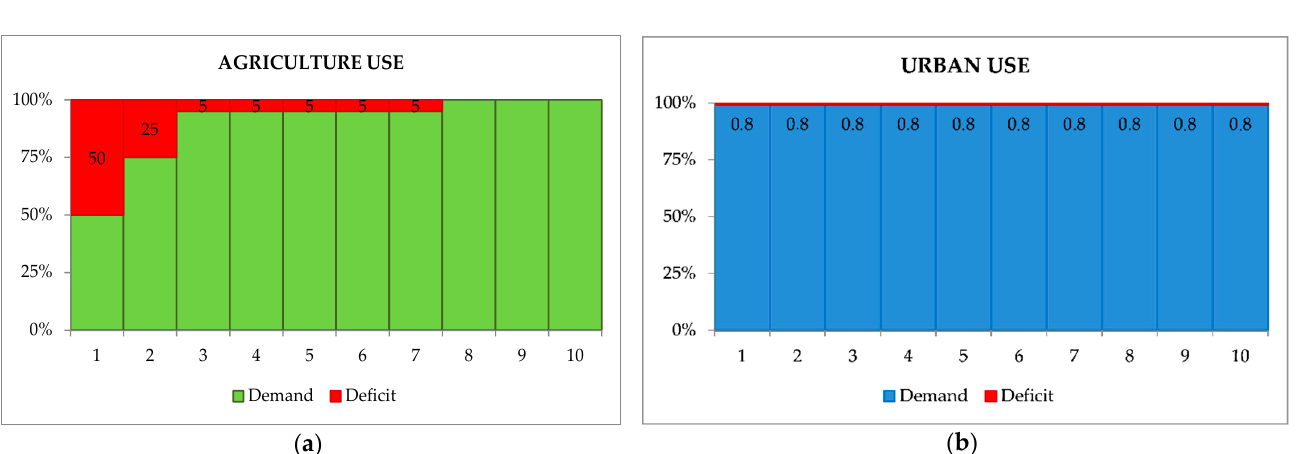
Table 10. Structural scarcity on the SRB. Source: own elaboration based on [34].